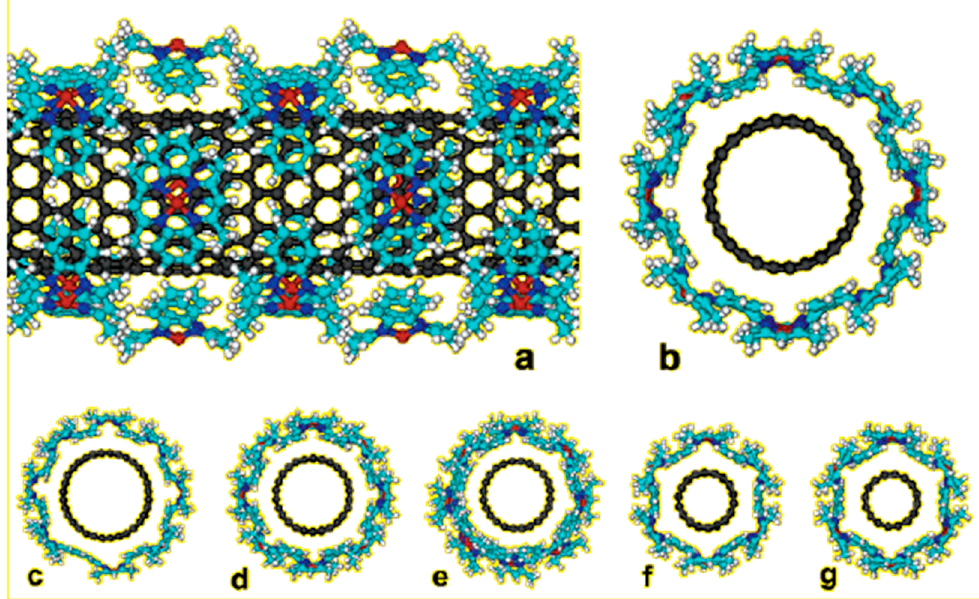
Figure 6. Aromatic annulene adsorbed on SWCNT walls. Exemplified for NiTMTAA and zigzag SWNTs: ( a , b ) (14, 0); ( c ) (16, 0); ( d ) (13, 0); ( e ) (12, 0); ( f ) (9, 0); and ( g ) (8, 0). Side view ( a ) and cross sections ( b – g ). Atom coloring: carbon, black (nanotube) and light-blue (complex); hydrogen, white; nitrogen [60].